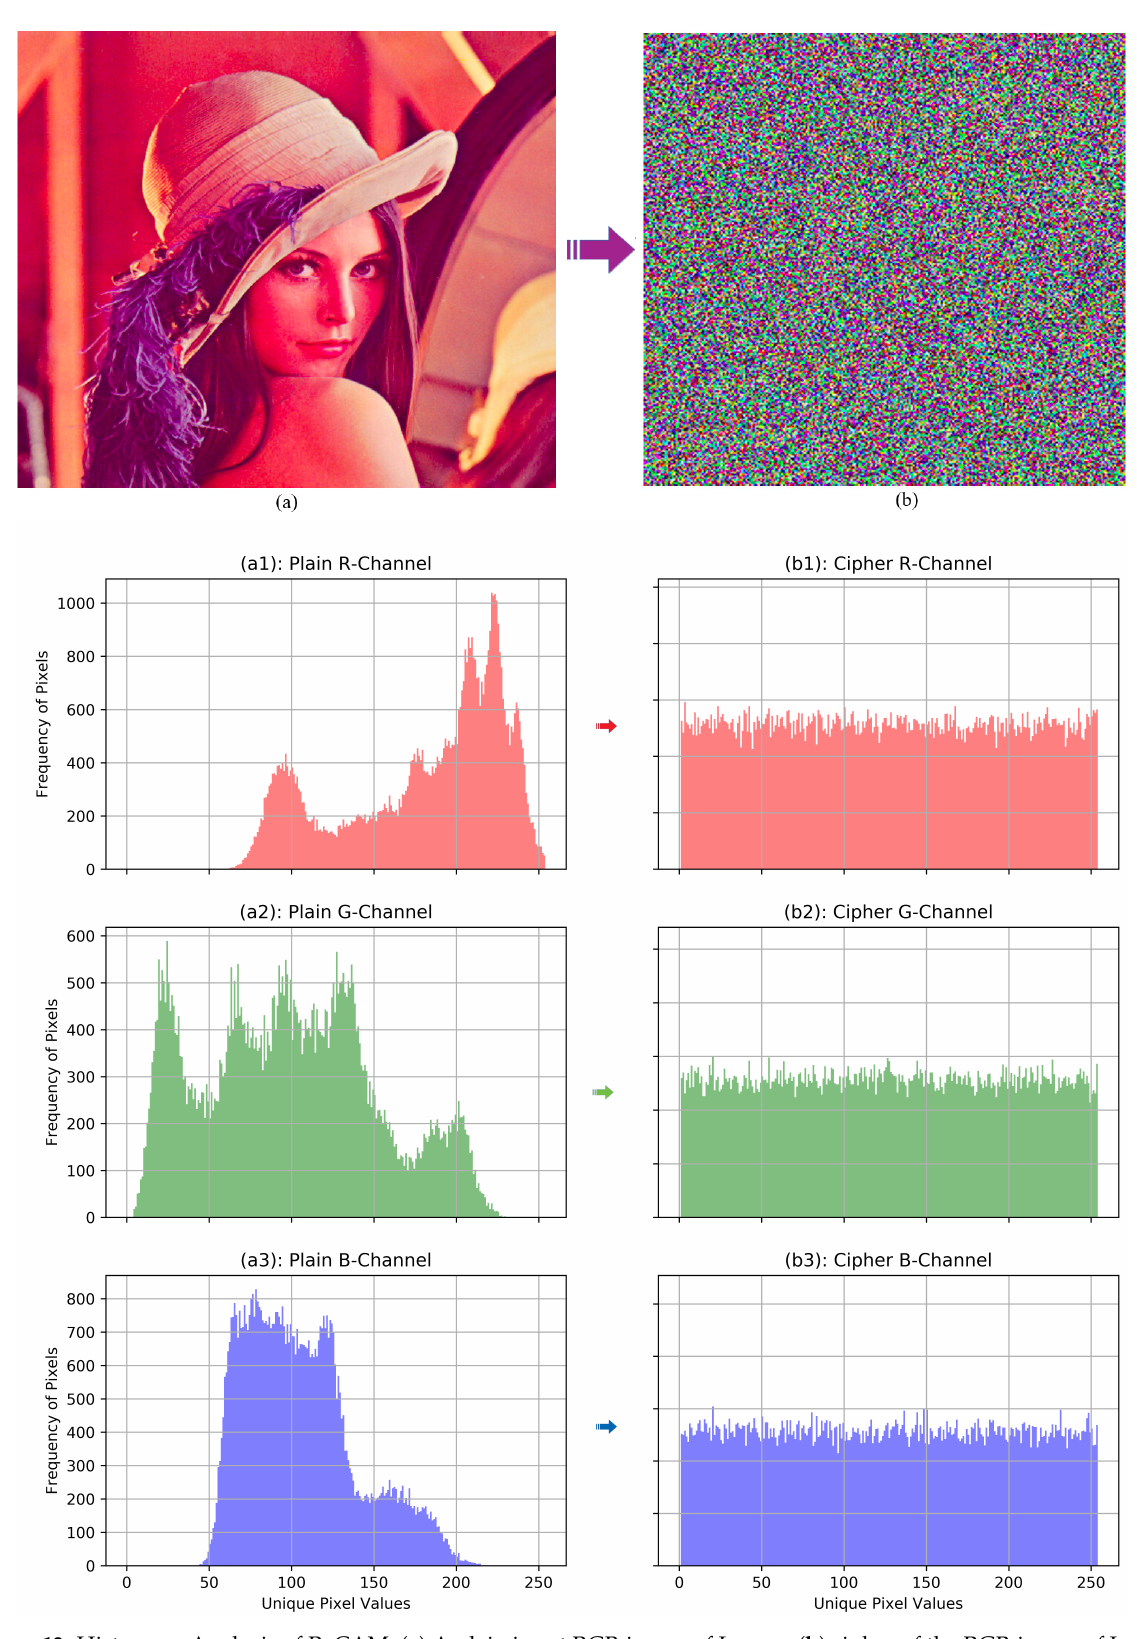
Figure 13. Histogram Analysis of ReCAM: ( a ) A plain input RGB-image of Lenna , ( b ) cipher of the RGB-image of Lenna ( a ), diagrams ( a1 ) through ( a3 ) are the histograms of the plain R, G, and B channels of clear input image ( a ), and diagrams ( b1 ) through ( b3 ) illustrate the histograms of the cipher R, G, and B channels of cipher image ( b